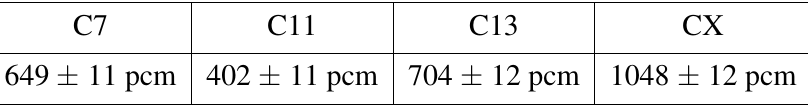
Table 1: Reactivity worths of the